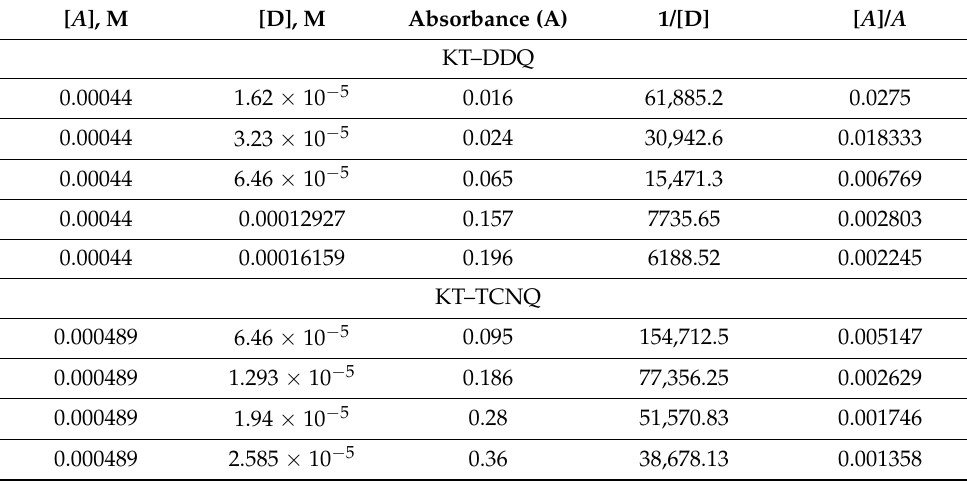
Figure 2. Job’s method to determine K:DDQ and KT:TCNQ ratios. Table 1. Benesi–Hildebrand data for the KT–DDQ and KT–TCNQ